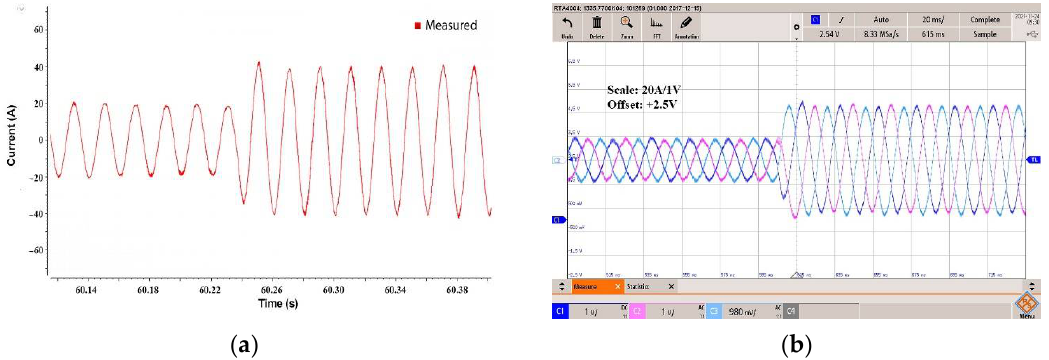
Figure 14. DSPACE-1202 front panel, Phase-A reference current at 40 A.